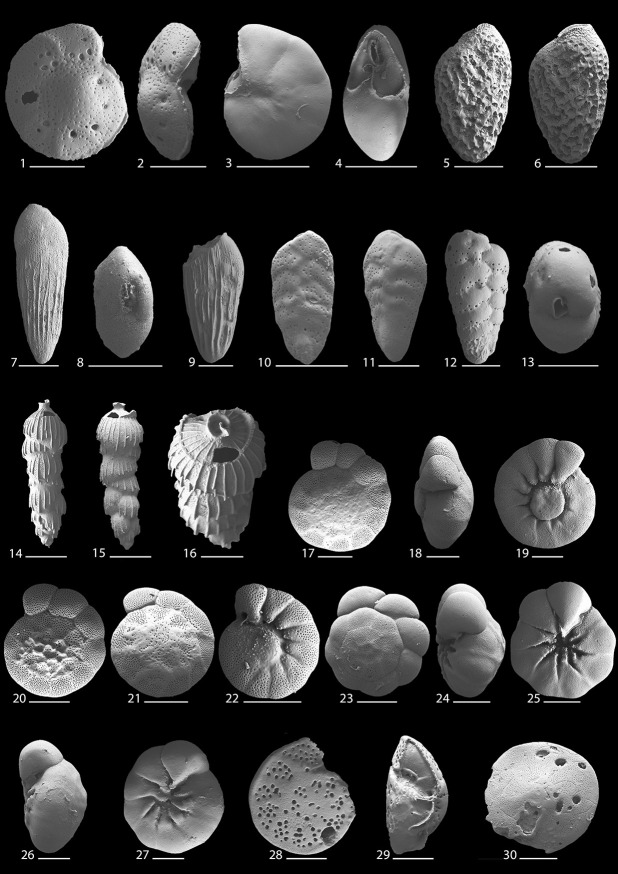
Scanning electron micrographs of benthic foraminifera from the Lagos Lagoon: 1, 2.Rotorbis? sp. 1; 3, 4. Globocassidulina? sp. 1; 5, 6. Bolivina cf. B. persiensis Lutze, 1974; 7–9. Bolivina striatula Cushman, 1922; 10, 11. Bolivina sp. 1; 12, 13. Bolivina sp. 2; 14–16. Rectuvigerina phlegeri Le Calvez, 1959; 17–22. Ammonia convexa Collins, 1978; 23–27. Ammonia aoteana (Finlay, 1940); 28, 29. Cibicides pseudolobatulus Perelis and Reiss, 1975; 30. Amphistegina sp. 1. Scale bar is 100 μm for all magnifications and 50 μm for Figs 13.1, 13.2, 13.9 and 13.11.